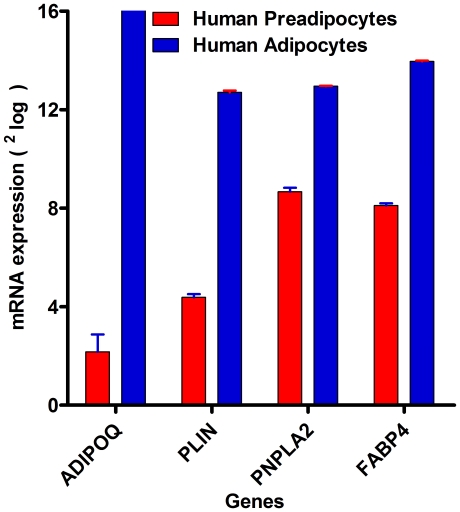
The differentiation markers for adipocytes.Illumina beadarray was used to screen adipocytes differentiation markers. These markers are Adiponectin (AdipoQ), perilipin (PLIN), adipose triglyceride lipase (PNPLA2) and fatty acid binding protein (FABP4). Gene expression was expressed as 2log (e.g. the difference between pre-adipocytes and adipocytes for adiponectin expression is approximately 10, thus the true difference is 210 ( = 1024-fold) and this is shown on the y-axis).